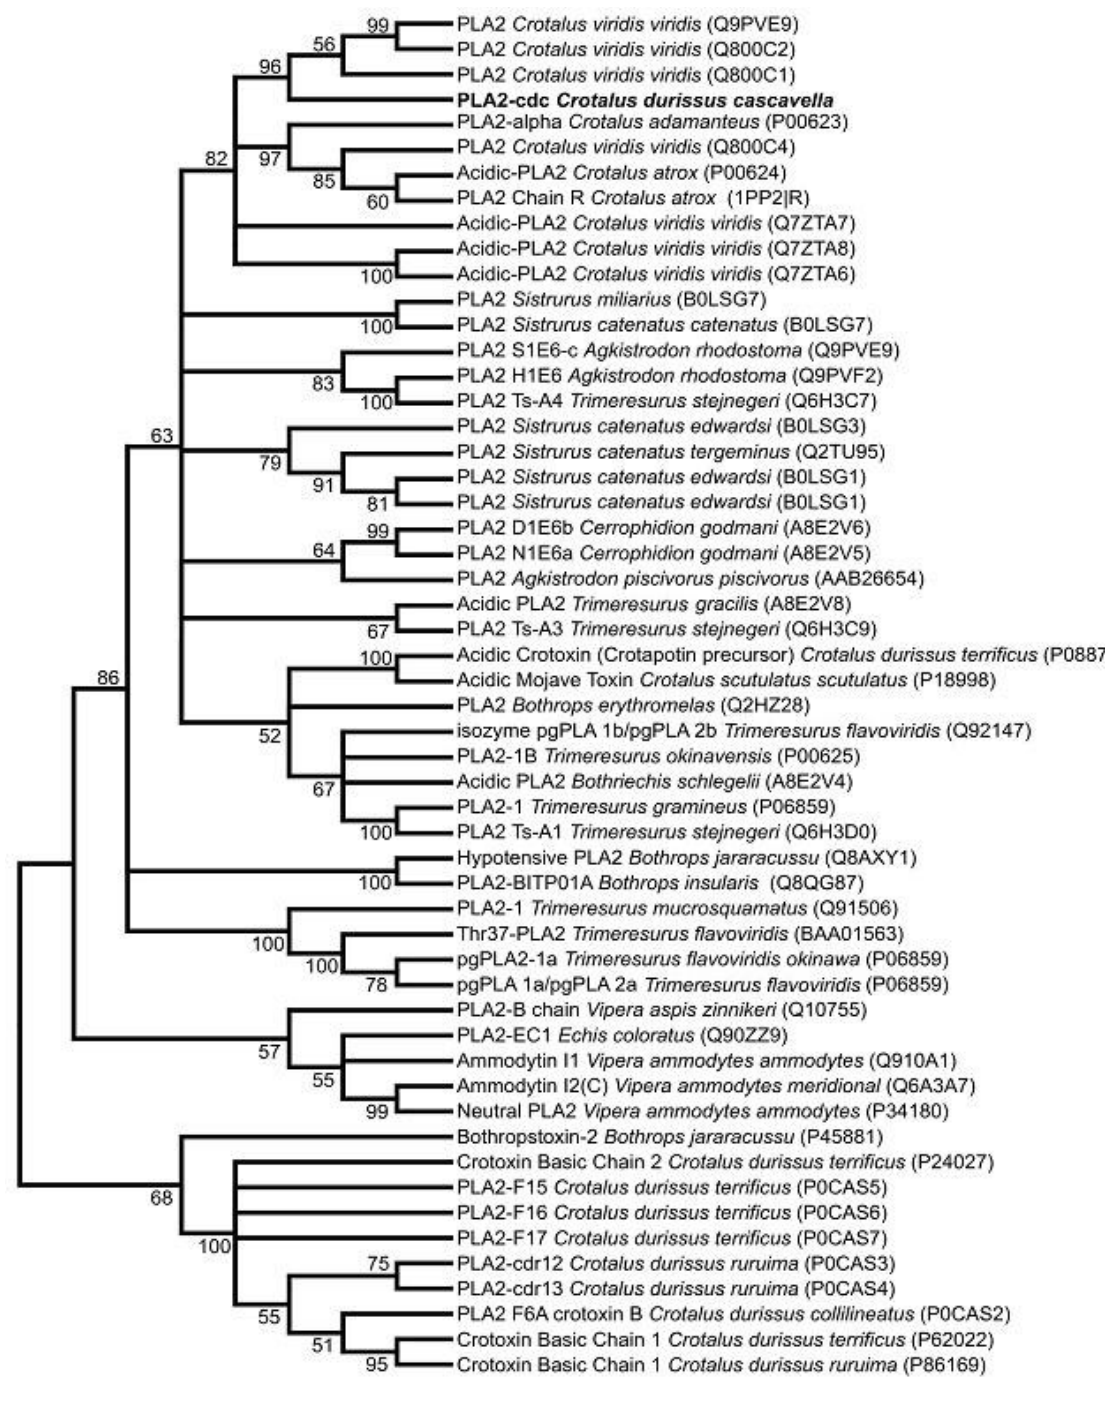
and Crotalinae venom PLA s. The 2 2